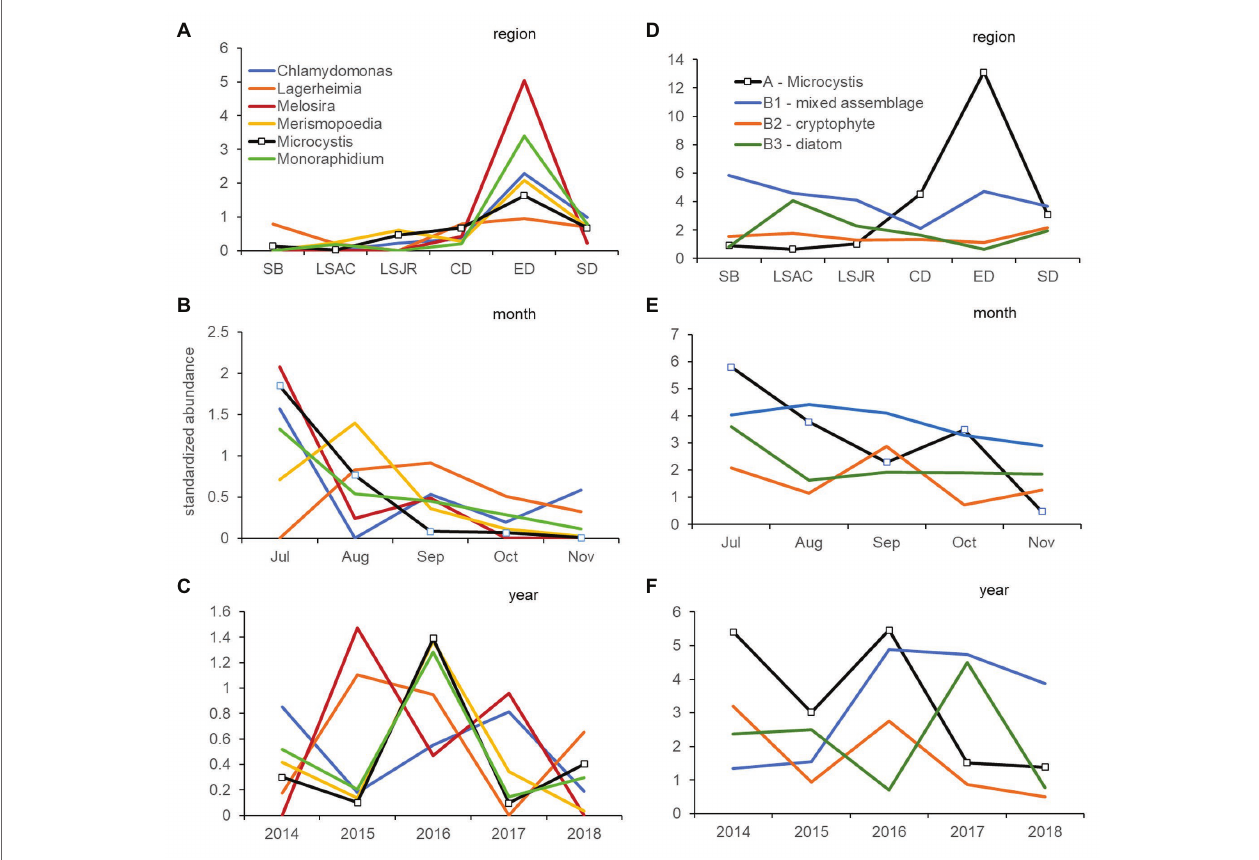
FIGURE 5 | Coherence curves describing the average standardized abundance (microscopy) of phytoplankton and cyanobacteria genera from significantly different (5% level) groups of genera identified by SIMPROF within cluster analysis. Curves describe the variation of each genus in Group A, which includes Microcystis , by region (A) , month (B) , and year (C) . A second set of coherence curves describes the variation of the average standardized abundance for Group A, compared with Group B1 (mixed phyla), Group B2 (cryptophyte genera), and Group B3 (diatom genera) by region (D) , month (E) , and year (F) . Samples were collected monthly at 10 stations in the USFE between 2014 and 2018. Please note difference in scales among